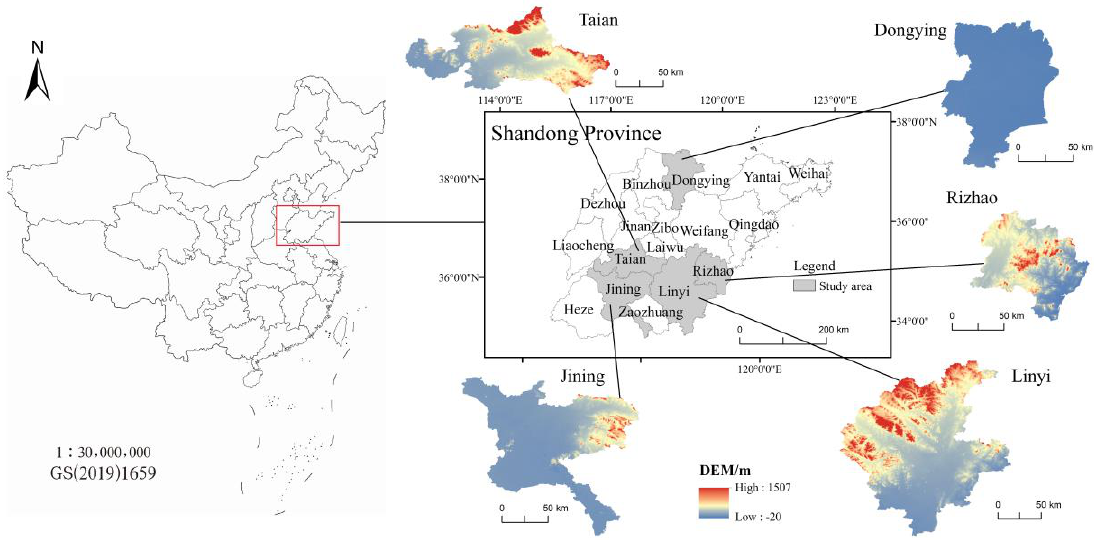
Figure 1. The location of the study area.